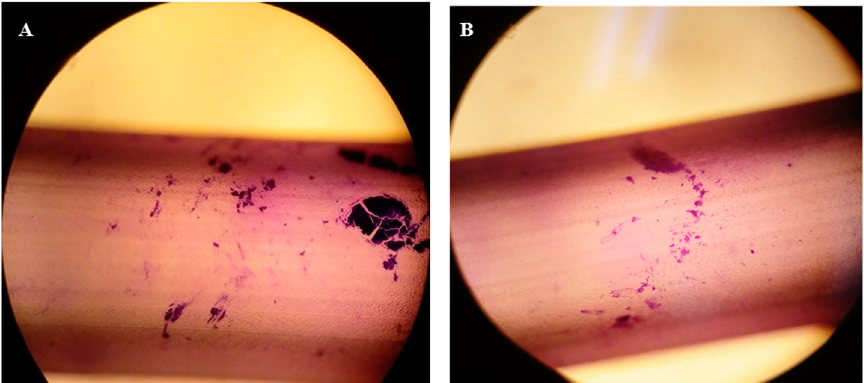
Figure 6. Optical microscope image of the K. pneumoniae ATCC 13884 biofilm assembled on the urethral catheter: ( A ) biofilm formation during acetaminophen treatment; and ( B ) without treatment with acetaminophen; both stained with crystal violet at 0.05%. Quantification of the area for each treatment was carried out using the ImageJ program, processing the sample by the particle content. Thus, the colonized area in the control sample was 2.07%, while in the acetaminophen sample it was 12.17%.